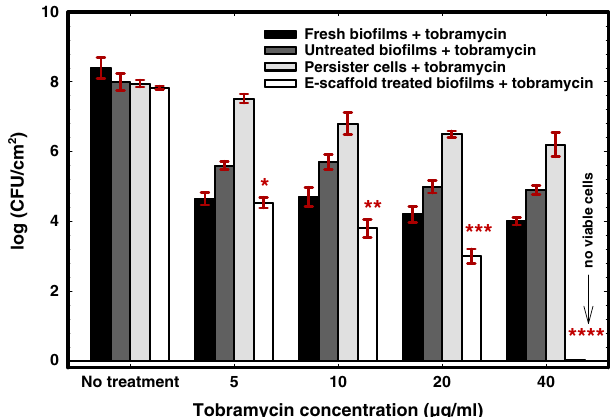
Fig. 1 E-scaffold enhances tobramycin susceptibility in P. aeruginosa PAO1 bio fi lms. Bars represent means of logarithms of colony- forming units of viable bio fi lm cells. Error bars represent the standard error of the means from three biological replicates. The symbols *, **, ***, and **** represent signi fi cant differences in tobramycin susceptibility between e-scaffold treated bio fi lms + tobramycin and untreated bio fi lms + tobramycin ( n = 3, *, P = 0.002 ; **, ***, **** P ≤ 0.001; paired t